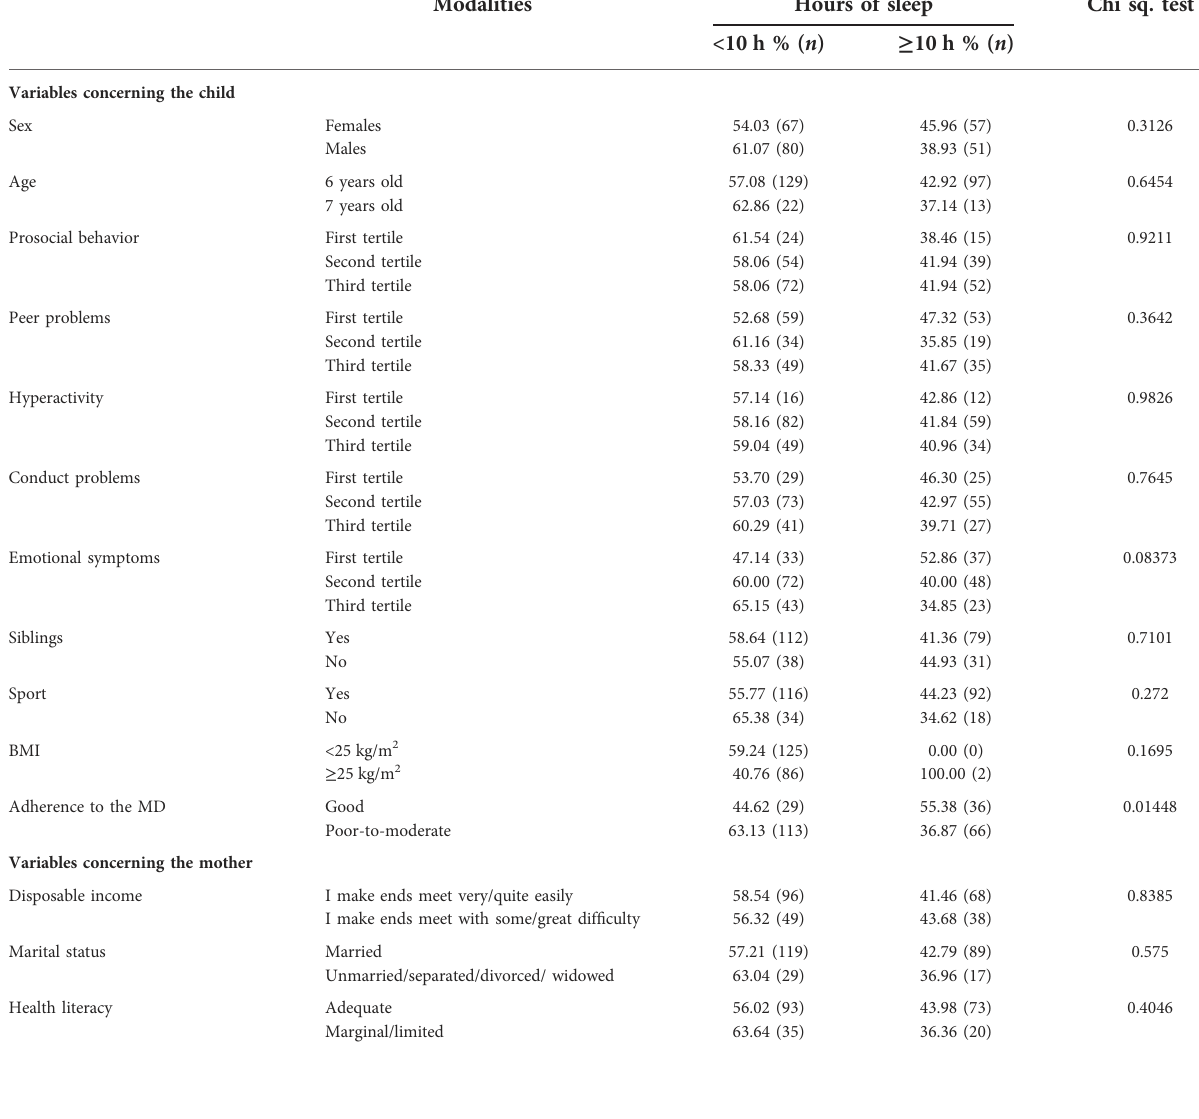
TABLE 2 Bivariate analysis. Distribution of hours of sleep among primary-school children by socio-demographic and lifestyle variables.